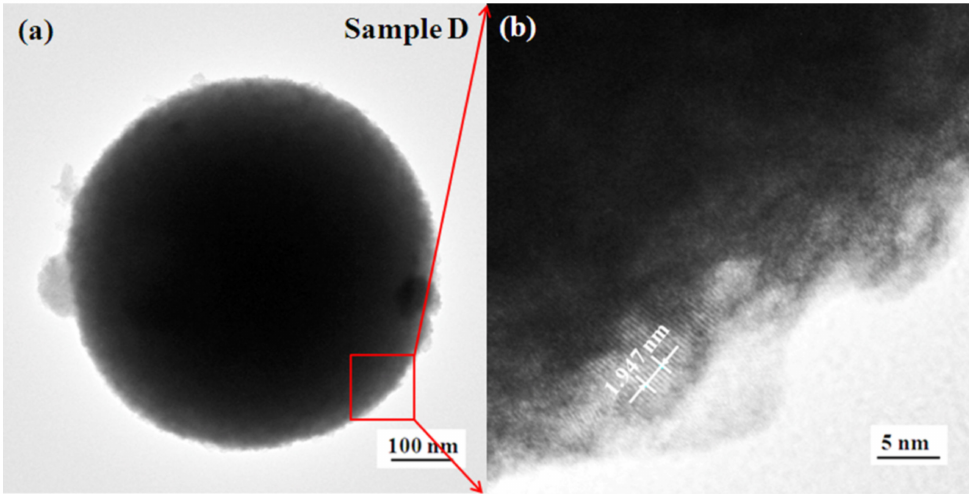
Figure 8. TEM images of sample D. Image ( a ) indicates that the edge is composed of nanoparticles. The high-resolution TEM image ( b ) indicates that the nanoparticle is the crystalline structure with a lattice spacing of ~0.389